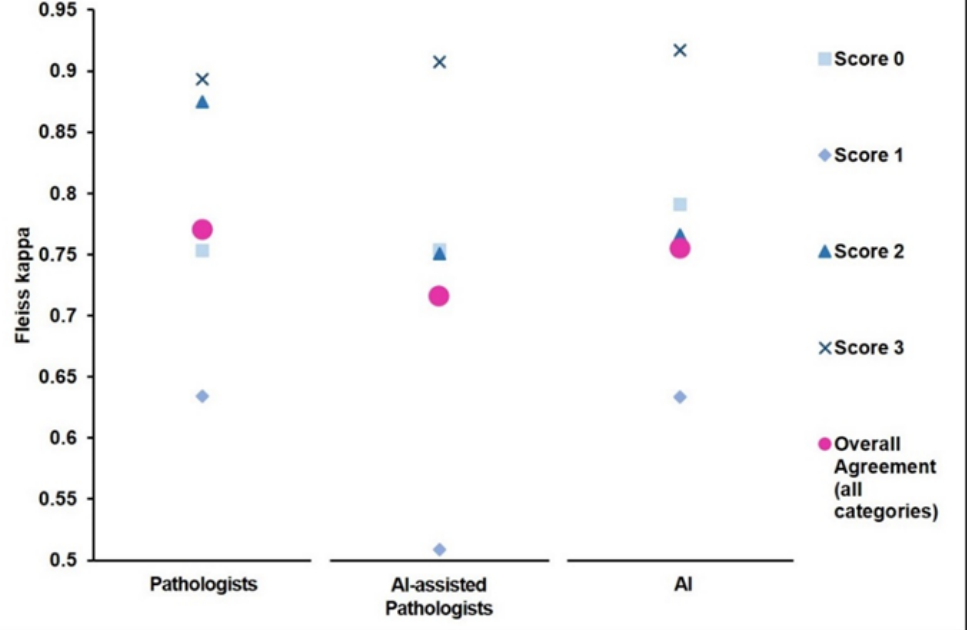
Figure 3. Evaluation of inter-observer agreement. Fleiss’ kappa for the measurement of inter-observer agreement amongst Pathologists, AI-assisted Pathologists, and AI on the IHC-stained slides. Agreement is presented for each IHC score and combined.